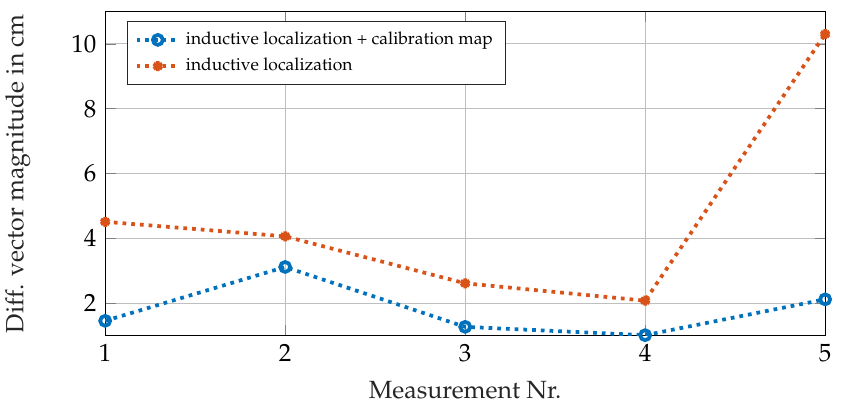
Figure 19. Lengths of the difference vectors between the measured position and the real position for just the inductive measurement system and the improvement of the results in using the calibra- tion